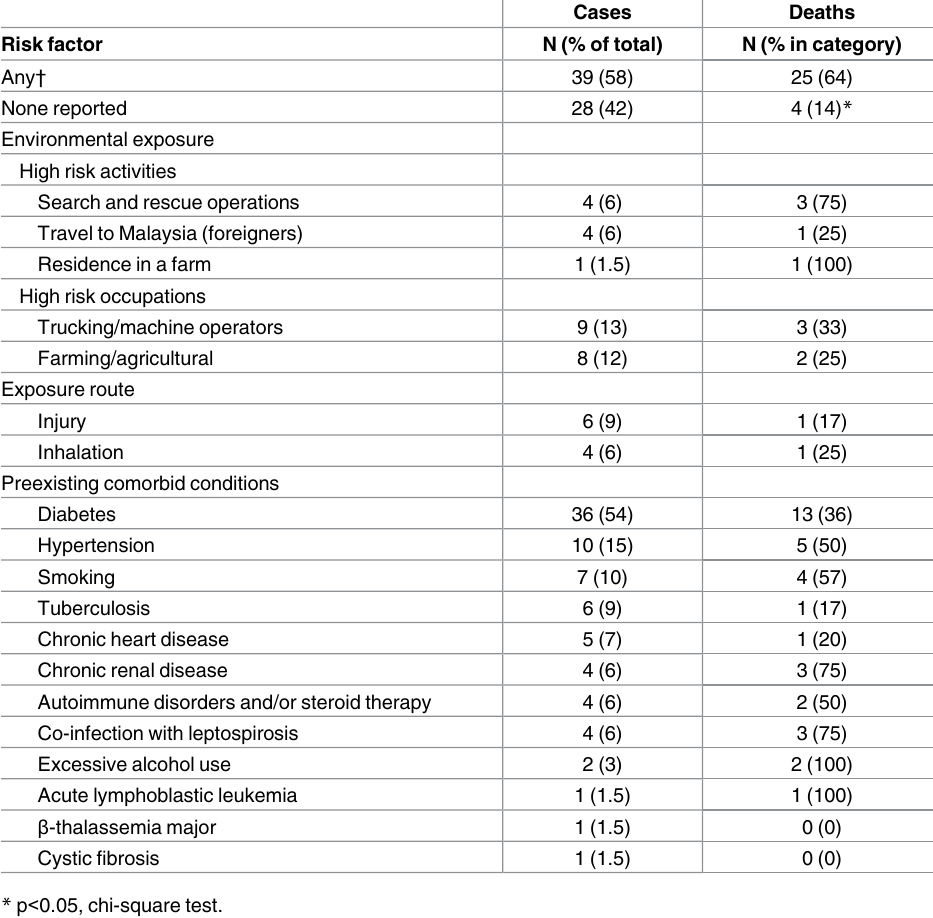
Table 2. Cases’ exposure history, risk factors and associated